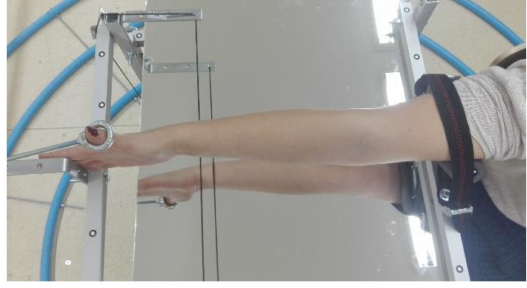
Figure 3. Forearm position during